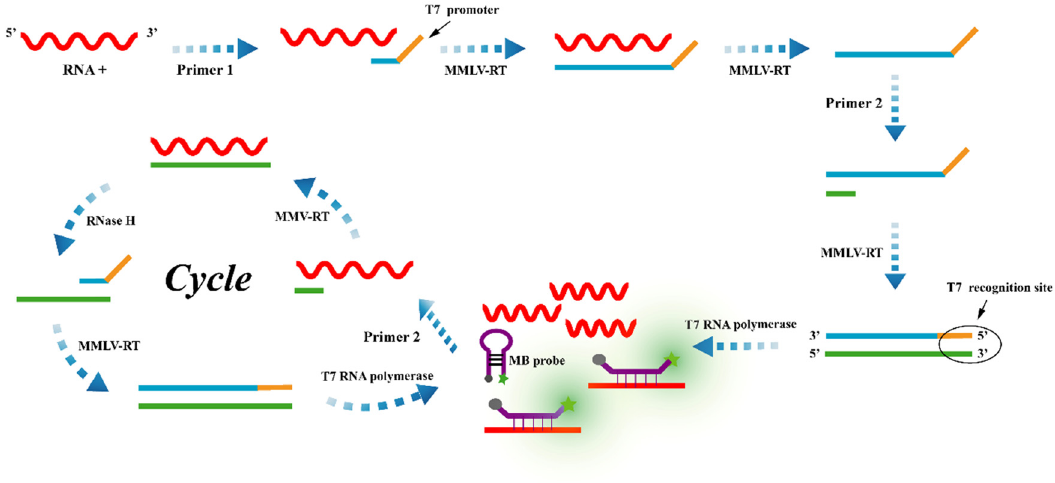
Figure 2: Schematic diagram represents SAT technology. MBs are probe molecules that exhibit a characteristic stem - loop structure through which the 5 ′ and 3 ′ ends are maintained in close proximity. At this time, the fl uorescence signals are quenched because the reporter groups and quencher groups are close to each other. The disruption of base - pairing in the stem, upon denaturation, allows the probe to hybridize to a complementary target. In this case, the reporter groups and the quencher groups are separated su ffi ciently, inducing the reporter groups to restore the fl uorescence signal. Thus, the target can be determined based on the real - time increase in the fl uorescence signal in the reaction system.